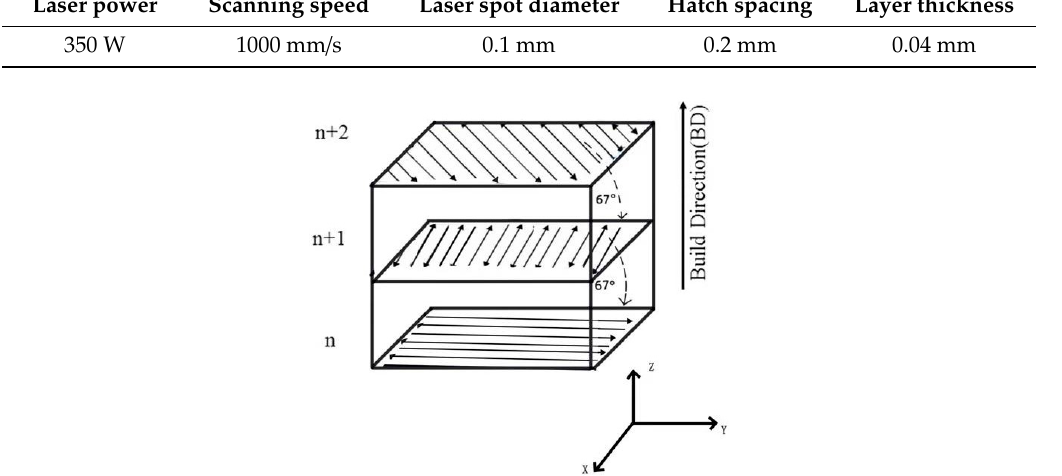
Figure 1. Scanning strategy of the selective laser melting (SLM)